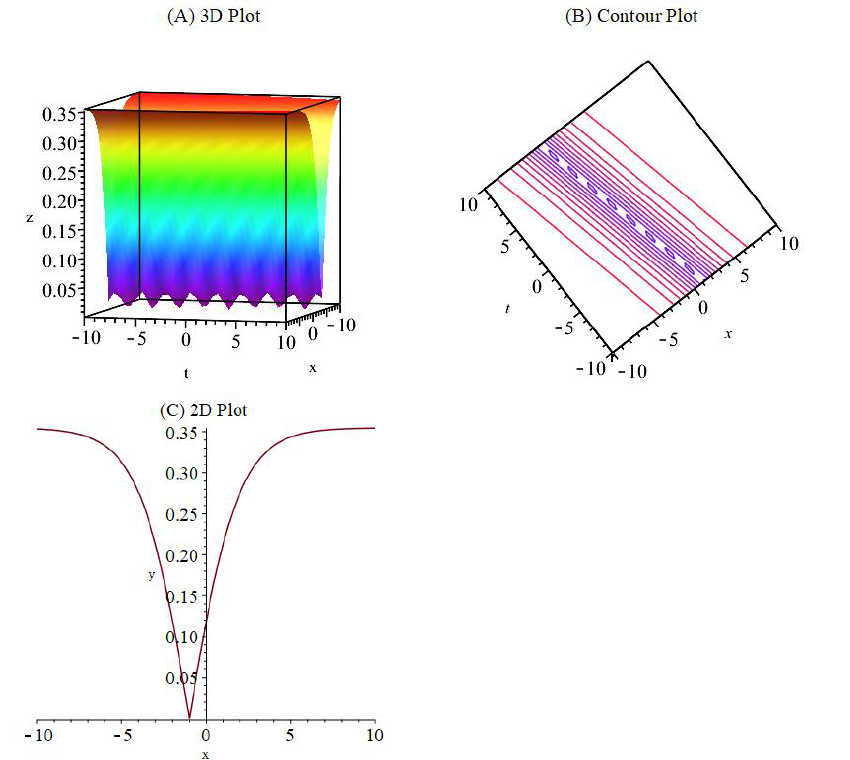
Figure 3. Two-dimensional and three-dimensional plots of the dark soliton solution | Equation ( 15 ) | for ε 1 = − 0.12, ε 2 = 0.55, ε 3 = − 1.2, ε 4 = 0.5, η 1 = 0.9, η 2 = 0.01, Γ = 2, a = 2, y = 0.